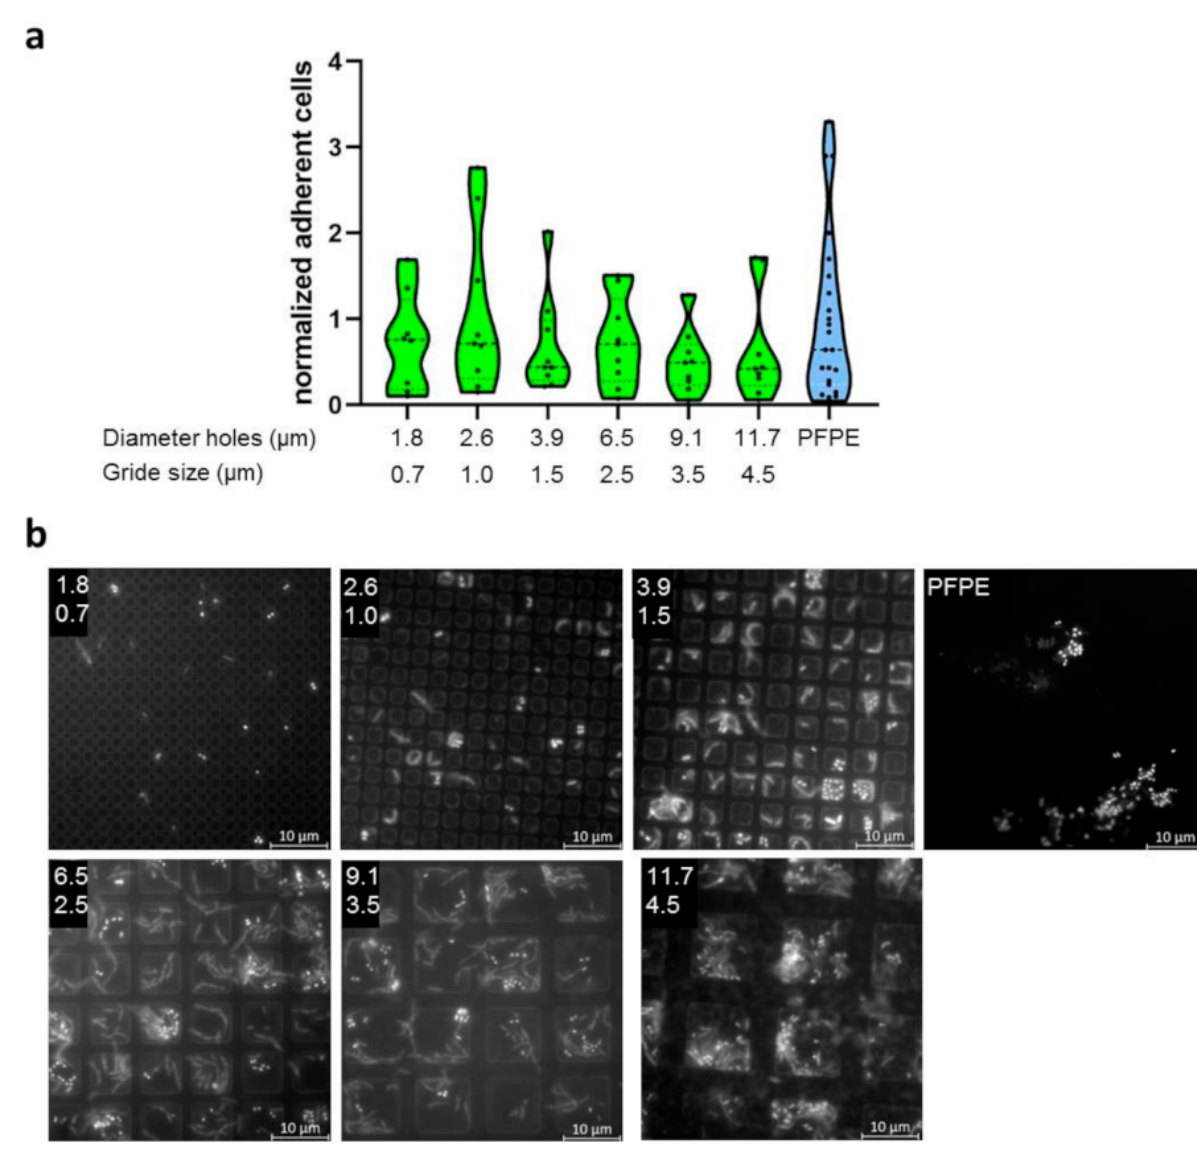
Figure 4. Adherence of microorganisms to specimens with hole structures of different dimensions. ( a ) Specimens made from PFPE containing holes of different dimensions were exposed to the oral cavity for 8 h. Here, only selected dimensions are shown, with the full dataset available in Supple- mentary Figures S4 and S7. Depicted is the number of adherent cells normalized to the adherence on plain PFPE. ( b ) Representative images of DAPI-stained specimens for the analyzed dimensions. The upper number indicates the diameter of the holes in µ m and the lower number the grid size in µ m. Microorganisms are mostly detected within the recessed hole-like